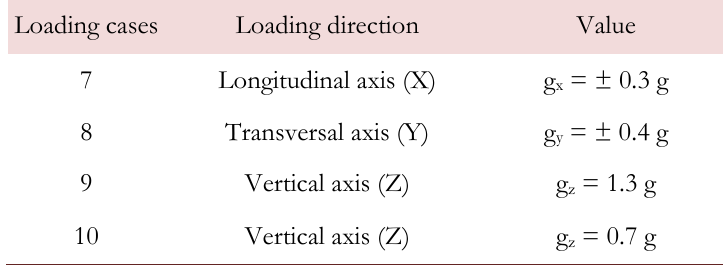
Table 5: Fatigue loading cases.